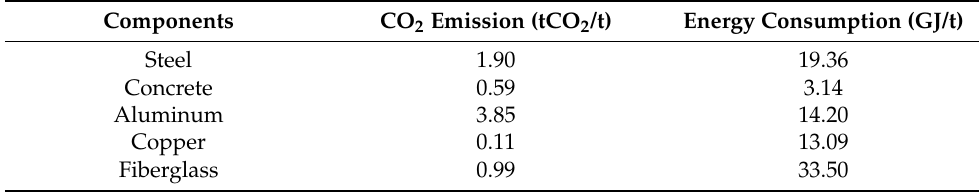
Table 2. CO 2 emission and energy consumption factors for manufacturing each material.